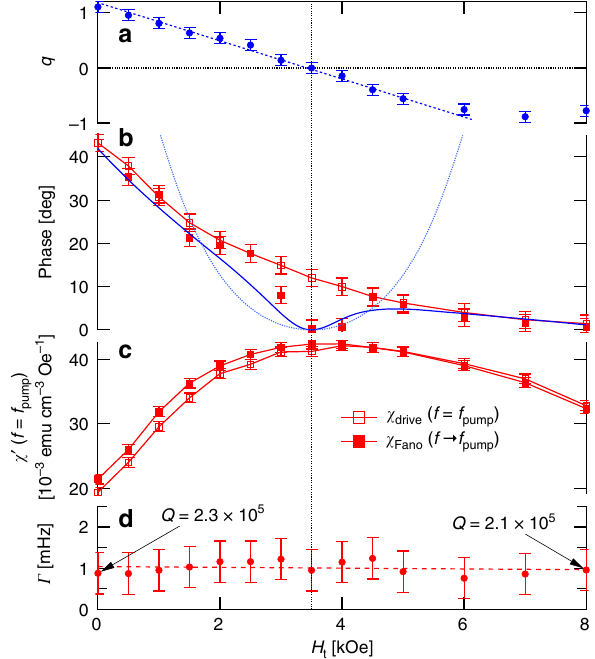
Fig. 5 Evolution of resonant behavior vs. pump amplitude at T = 0.11 K and H = 0 for a 202 Hz pump. a Fano parameter q vs. drive amplitude showing t a continuous evolution including a smooth crossing through zero. Dashed